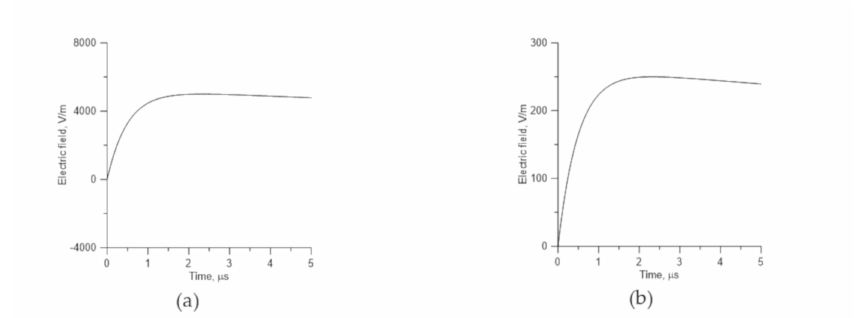
Figure 4. The electric field at ground level at a distance of ( a ) 100 m and ( b ) 2 km from the strike as predicted by Equation (50). The current at the channel base is assumed to be given by